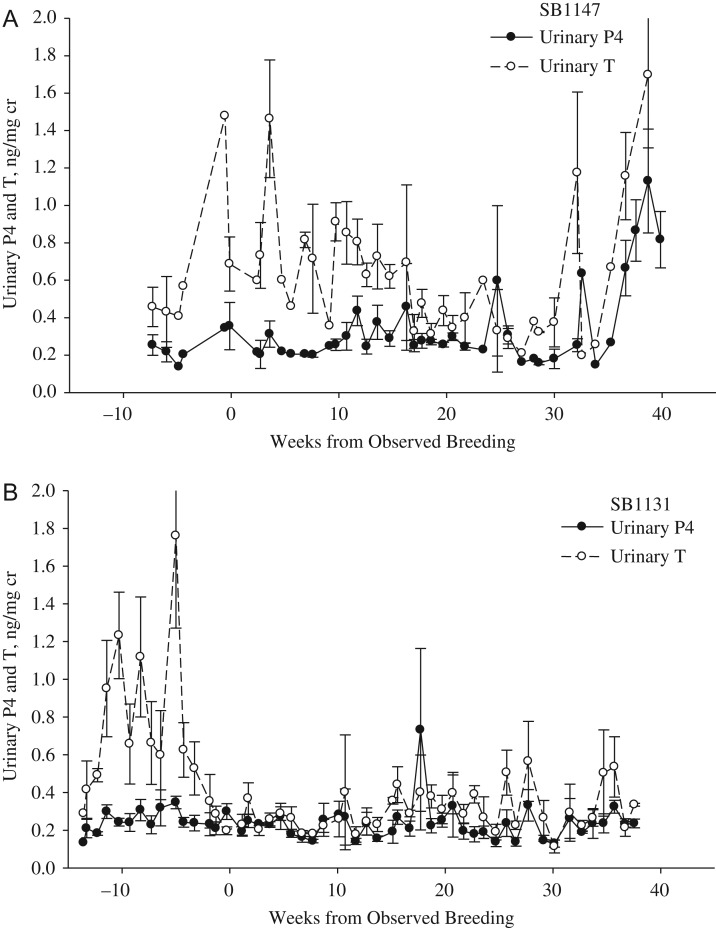
Weekly progestin (P4) and androgen (T) concentrations (mean ± SEM) in urine from captive female polar bears during presumed anovulatory cycles as aligned to the last day of observed breeding (n= 2 reproductive cycles for each female). (A) The cylces for SB1147, 2011–12 and (B) the cycles for SB1131, 2012–13.